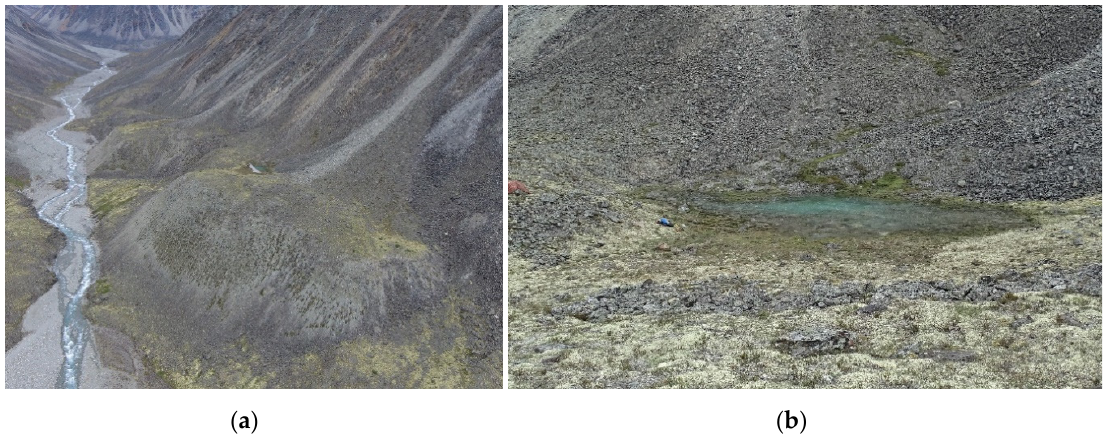
Figure 11. Morphology of rock glacier No. UC-1 ( a ) and a temporary lake on its surface ( b ), which forms during heavy precipitation.